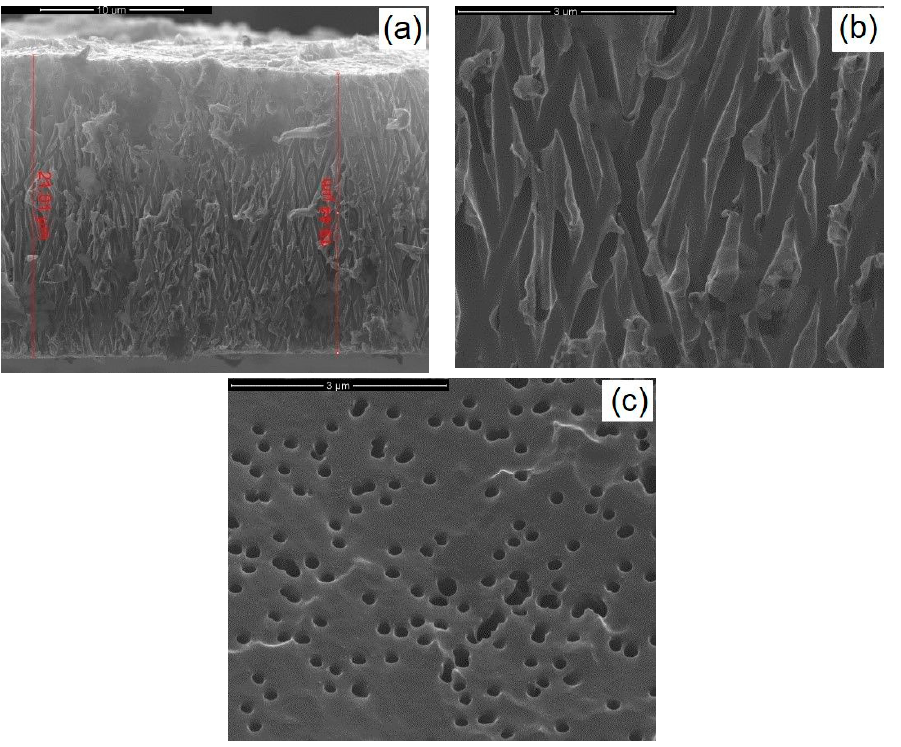
Figure 2. Micrographs of a polycarbonate membrane ( a ) with cross-section ( b ) and top ( c ) views.